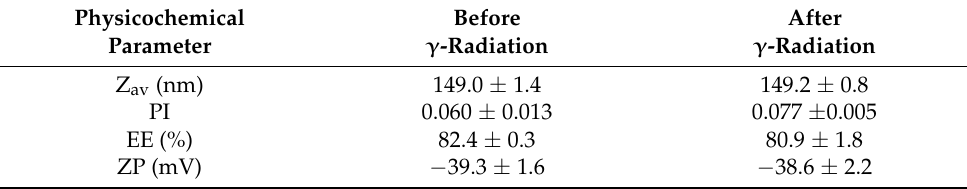
Table 3. Physicochemical characterization of DCF NPs before and after γ